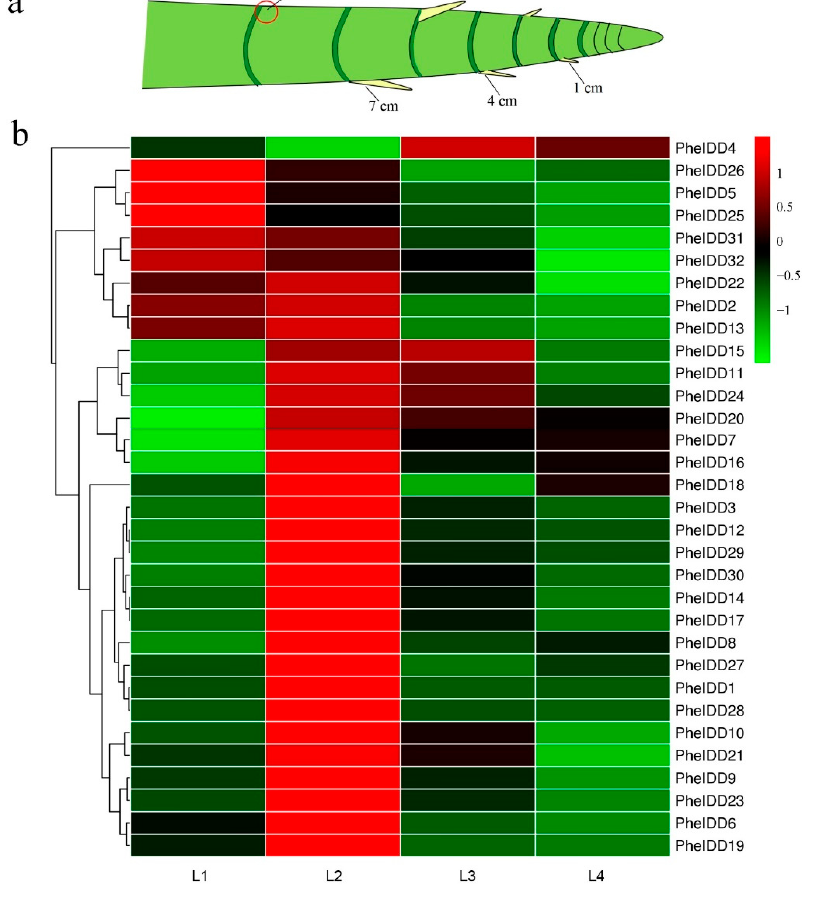
Figure 7. Expression patterns of PheIDD family genes in aboveground branches of different sizes. ( a ) Schematic diagram of aboveground branches. ( b ) Expression heatmap of PheIDD genes in aboveground branches of different sizes. The color scale indicates the relative expression level. Green in color scale erected vertically at the right side of the picture indicates lower transcript abundance compared to the relevant control, and red indicates higher transcriptabundance. L1: 0-cm bud; L2: 1-cm branch; L3: 4-cm branch; L4: 7-cm branch. The PheNTB gene was used as a reference. The qRT–PCR results were obtained from three biological and three technical replicates.